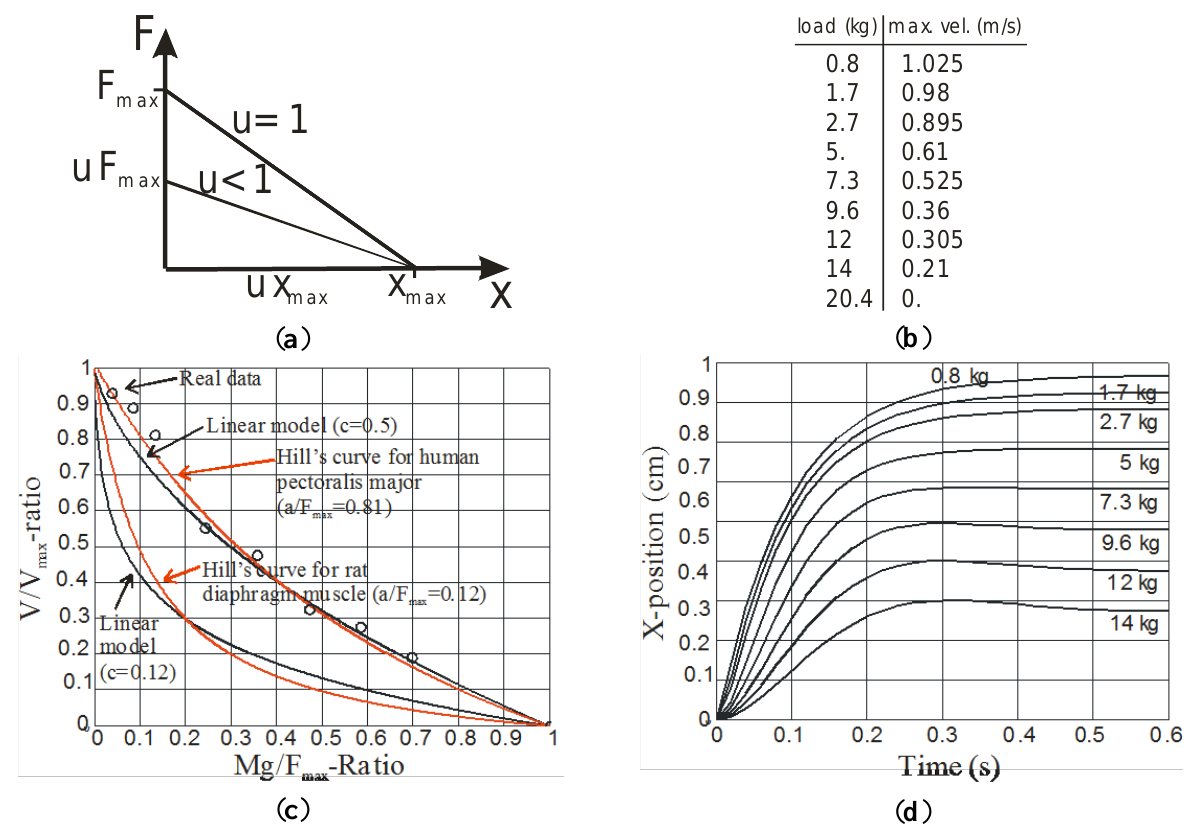
Figure 5. Biomimetic artificial muscle and its comparison with the skeletal muscle, ( a ) force/position characteristic, ( b ) real data used for the comparison between a human pectoralis major and the proposed biomimetic artificial muscle with a linear viscous damping (rewritten from [23]), ( c ) comparison between the force/velocity characteristic with u = 1 in two extreme cases of Hill’s curve—the circles correspond to the real data given in (b)—(see text), and ( d ) time-simulation of the quick-release of the biomimetic artificial muscle in load conditions given in